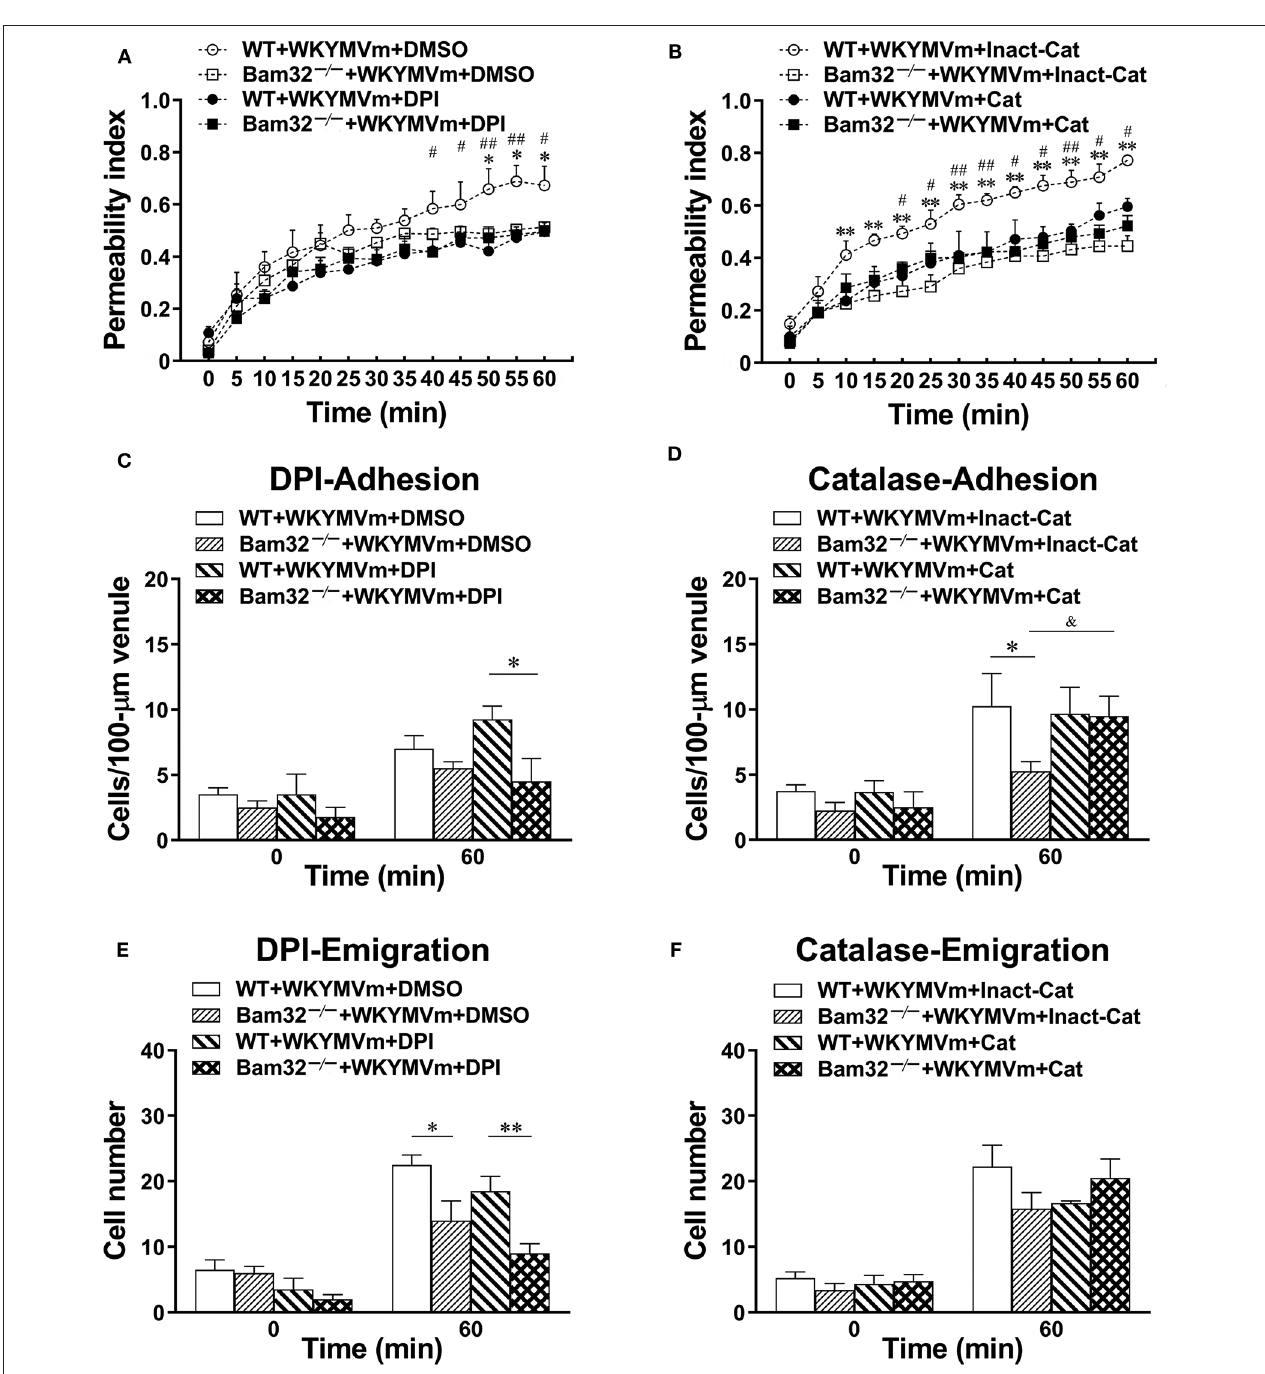
FIGURE 4 | Pharmacological inhibition of reactive oxygen species generation in WKYMVm-induced microvascular hyperpermeability. (A) Permeability indices of mouse cremasteric post-capillary venules following 60-min WKYMVm (0.1 µ M) superfusion in the presence of vehicle (DMSO) or DPI (40 µ M) for 30min prior to and during 60-min WKYMVm superfusion. (B) Permeability indices of mouse cremasteric post-capillary venules following 60-min WKYMVm superfusion in the presence of inactivated catalase (Inact-Cat) or functional catalase (Cat, 200 units/mL) for 30min prior to and during 60-min WKYMVm superfusion. Neutrophil adhesion number of 100- µ m length of venule (C) and neutrophil emigration number ( E , cells/443 × 286 µ m 2 field) were determined simultaneously in the same experiments of WKYMVm-induced cremasteric microvascular hyperpermeability before (0min) and 60min following superfusion with WKYMVm in the presence of DMSO or DPI. Neutrophil adhesion number of 100- µ m venule (D) and neutrophil emigration number ( F , cells/443 × 286 µ m 2 field) were determined simultaneously in the same experiments of WKYMVm-induced cremasteric microvascular hyperpermeability before (0min) and 60min following superfusion with WKYMVm in the presence of inactivated catalase or functional catalase. (A–F) mean ± SEM, n = 4–6. Significant differences between WT and Bam32 − / − mice (* p < 0.05 and ** p < 0.01). Significant differences between WT mice with or without DPI or functional catalase ( # p < 0.05 and ## p < 0.01). Significant difference between Bam32 − / − mice with functional catalase and with inactivated catalase ( & p <